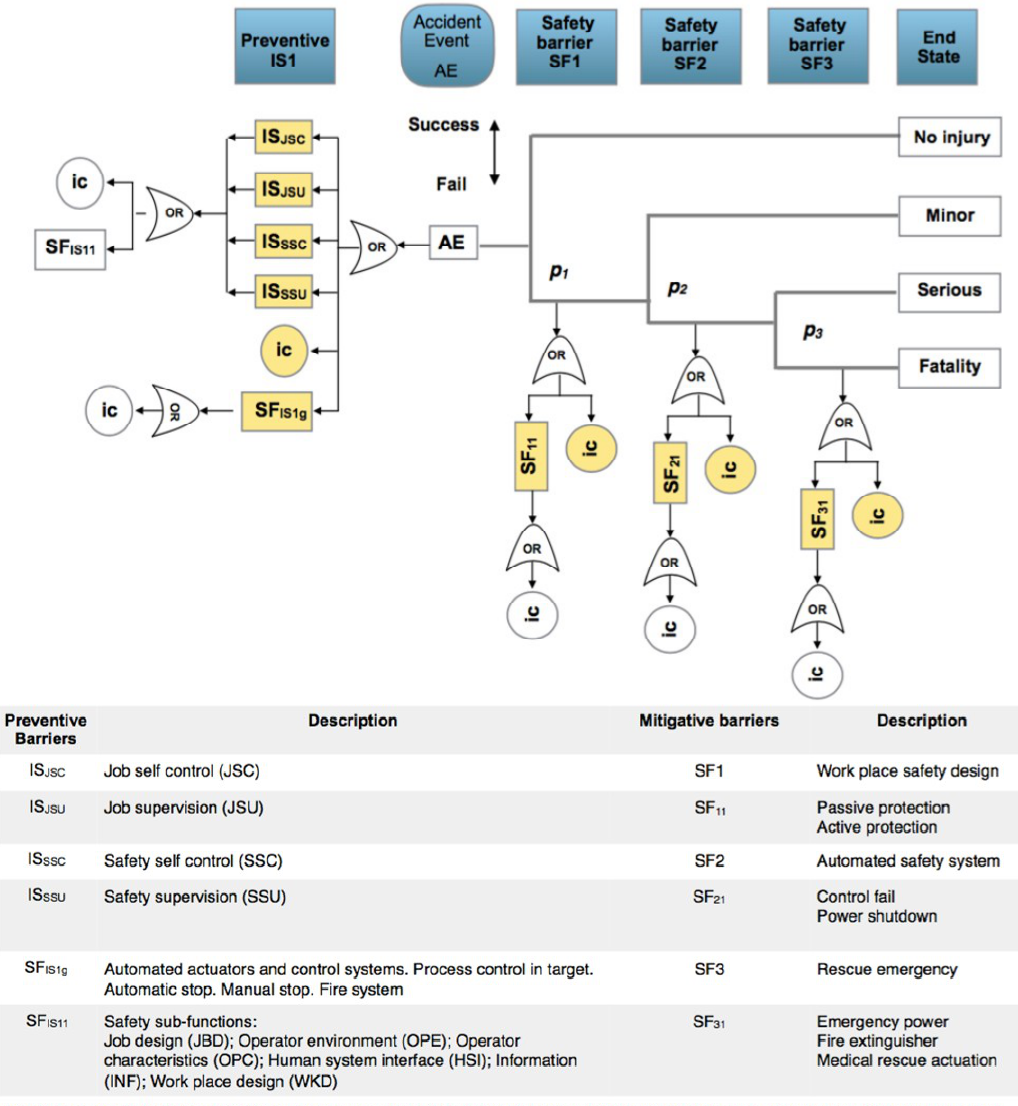
Figure 12. Bow-tie for occupational accident first level analysis in the MDF process plant.